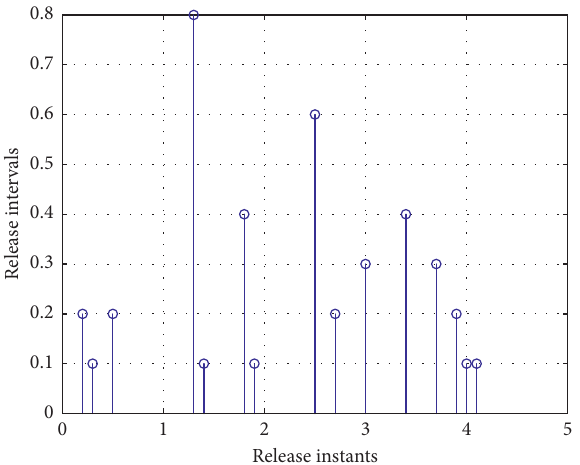
Figure 9: Release instants and intervals for Example 2.